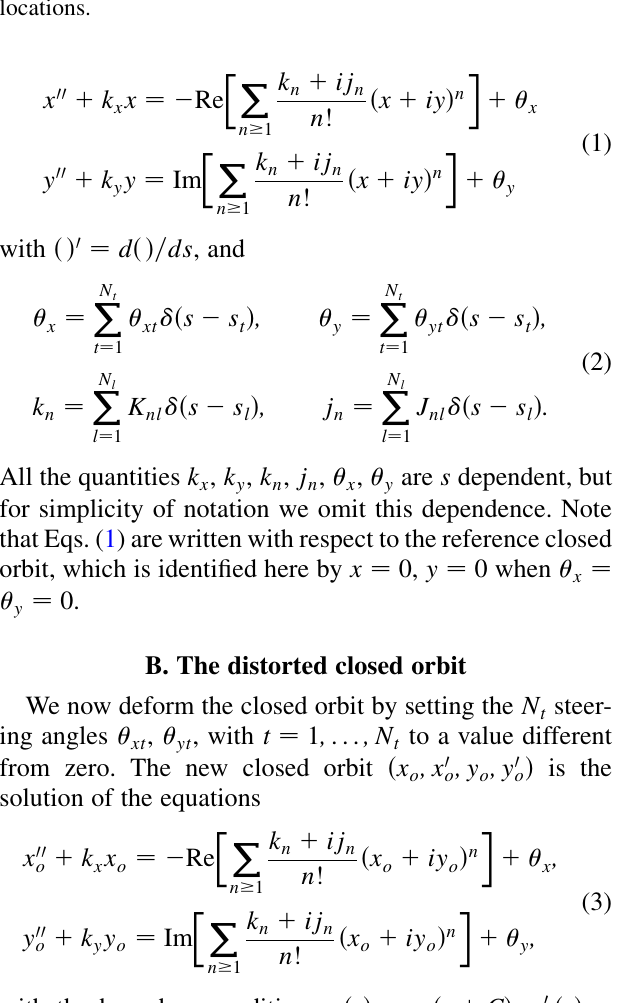
FIG. 1. (Color) Schematic of the nonlinear error and steerer